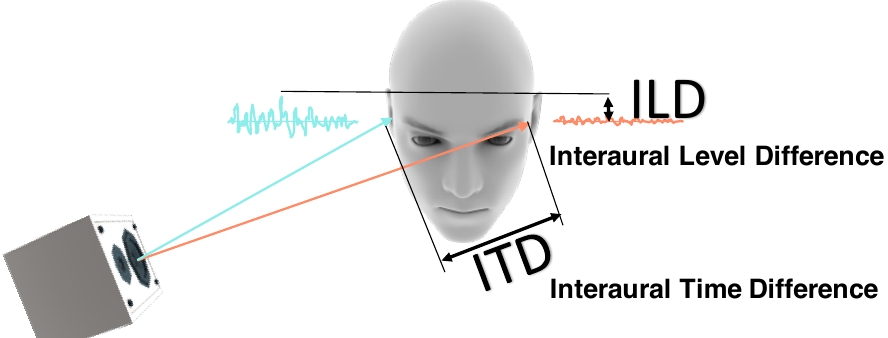
Figure 6. Interaural Time Difference (ITD) and Interaural Level Difference (ILD) between left and right